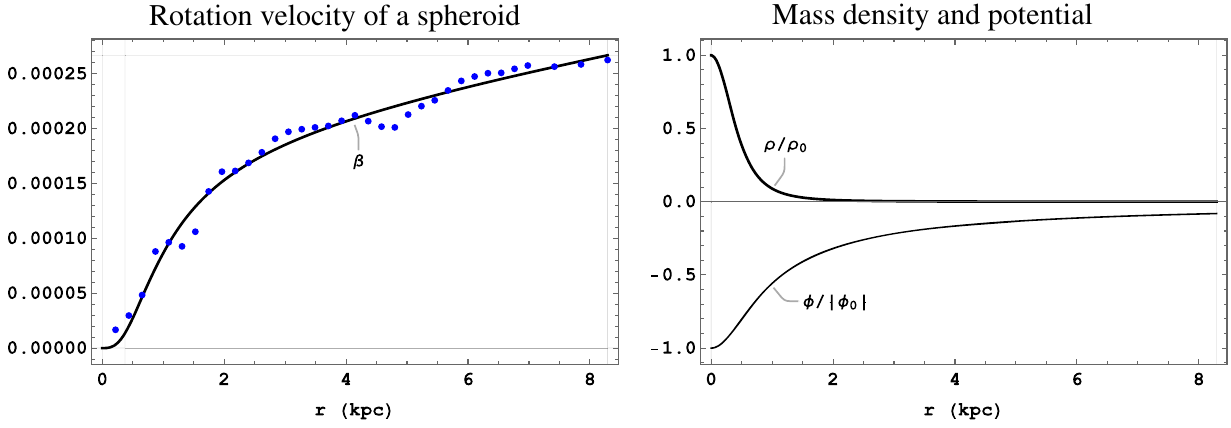
Fig. 1 The left-hand side graphic shows the rotation curve of a com- pact spheroid fitted to the measured values for NGC 1560 (dots) as listed by Broeils [32]. The right-hand side graphic shows the normal-